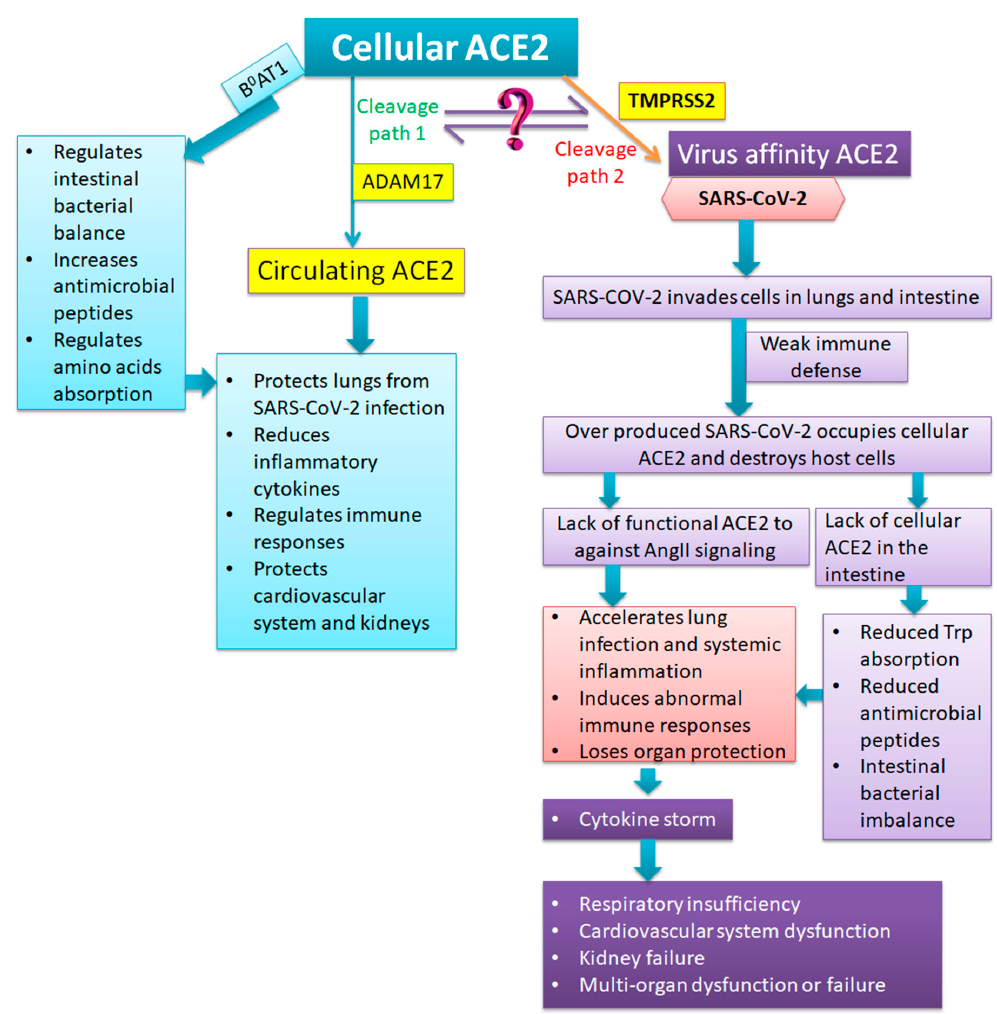
Figure 3. Hypothesis of ACE2 and the pathogenesis of severe and critical COVID-19.